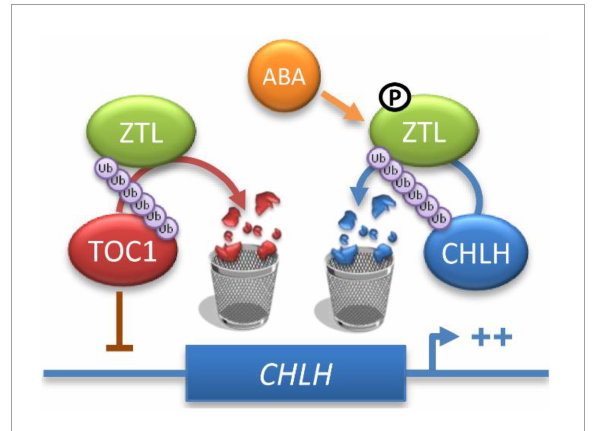
FIGURE7 Proposed model for ZTL action in ABA signaling. ZTL may regulate the expression of CHLH by TOC1 at the mRNA level. In addition, ZTL also modulates CHLH stability via the 26S proteasome pathway, and ABA enhances CHLH proteasomal degradation. Therefore, ZTL regulates the expression of CHLH at both transcriptional and post-transcriptional